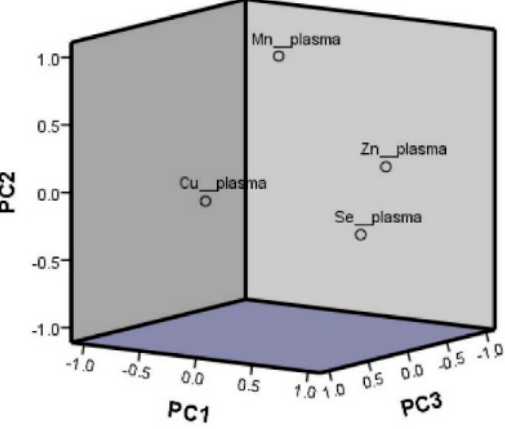
Figure 1. Principal component analysis loading plots for the rotated (varimax rotation) components for the combined plasma trace elements (Zn, Cu, Se, and Mn) in the studied population. PC: principal component.